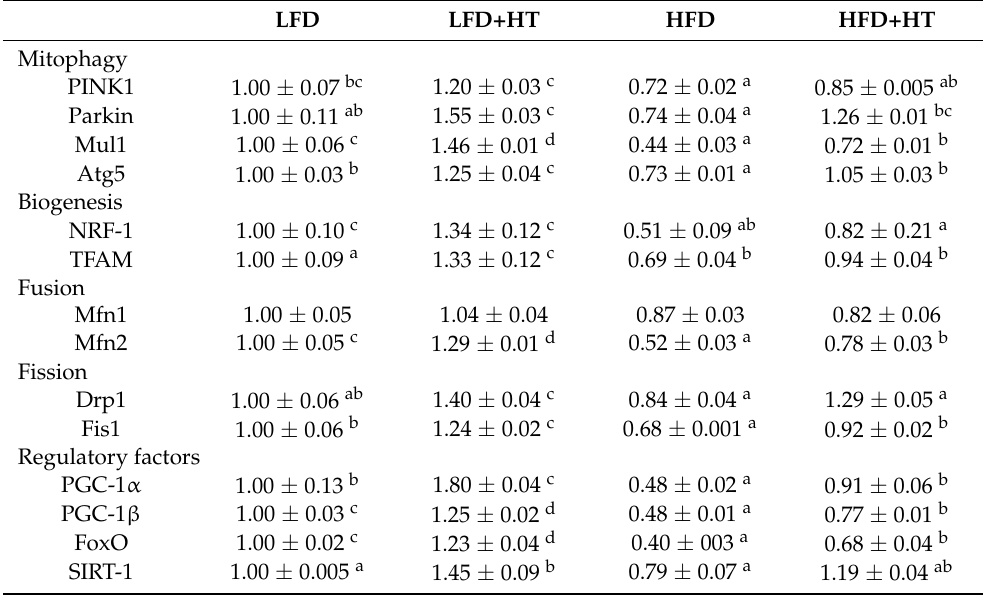
Table 5. Mitochondrial remodeling in the liver of blunt snout bream fed with experimental